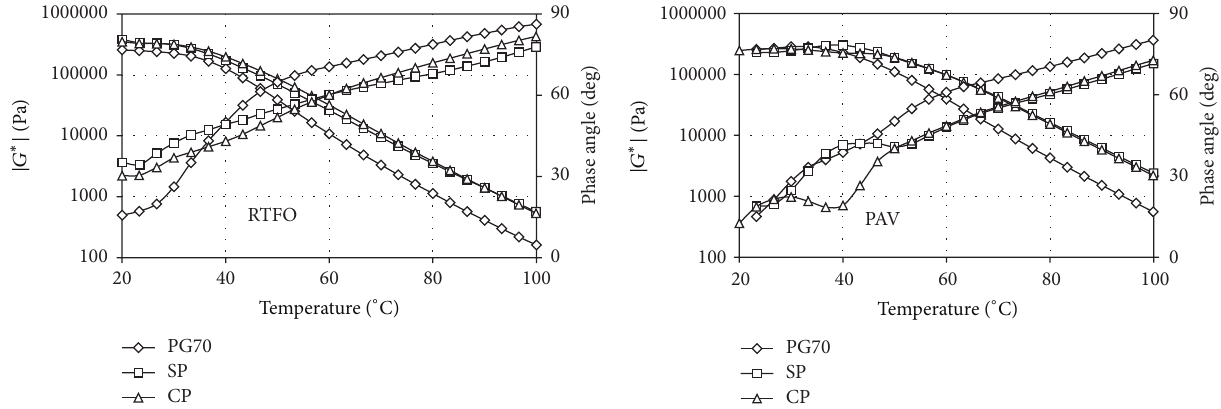
Figure 1: Isochronal plots for RTFO and PAV aged PMB.